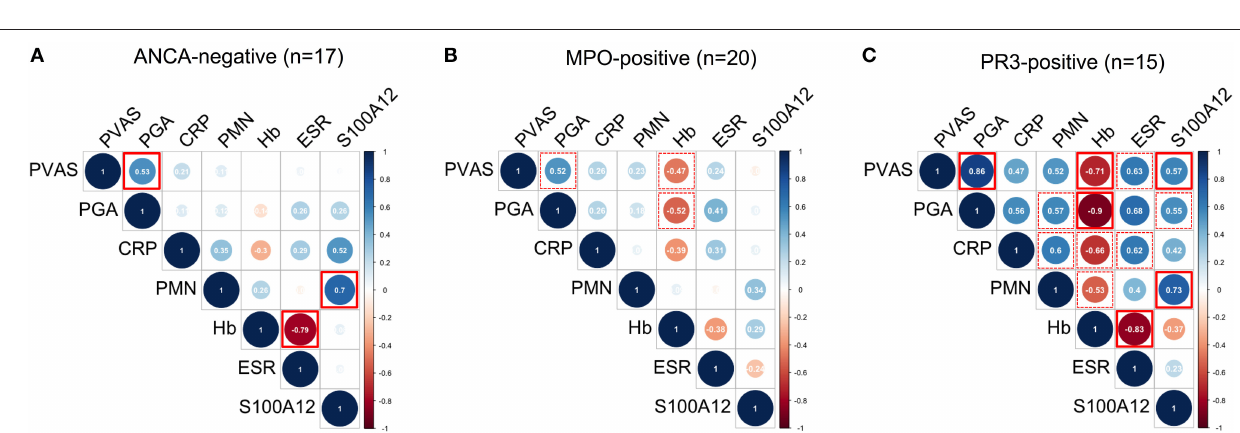
FIGURE 4 | Multiple correlation analyses of laboratory markers and clinical disease activity scores. Correlograms show spearman correlations of clinical disease activity scores (PVAS and PGA) with quantified measures of inflammation: concentration of C-reactive protein (CRP), erythrocyte sedimentation rate (ESR), concentration of hemoglobin (Hb), absolute polymorphonuclear leukocyte (PMN) count, and concentration of S100A12 in samples (n) obtained from ANCA-negative (A) MPO-positive (B) and PR3-positive (C) CPV patients. Color indicates positive (blue) and negative (red) correlation. Color intensity and circle diameter indicates strength of the correlation (red: − 1 to blue: + 1). Dash red boxes indicate significant correlations, red boxes with full lines indicate significant correlations following Holm-Bonferroni correction for multiple correlation